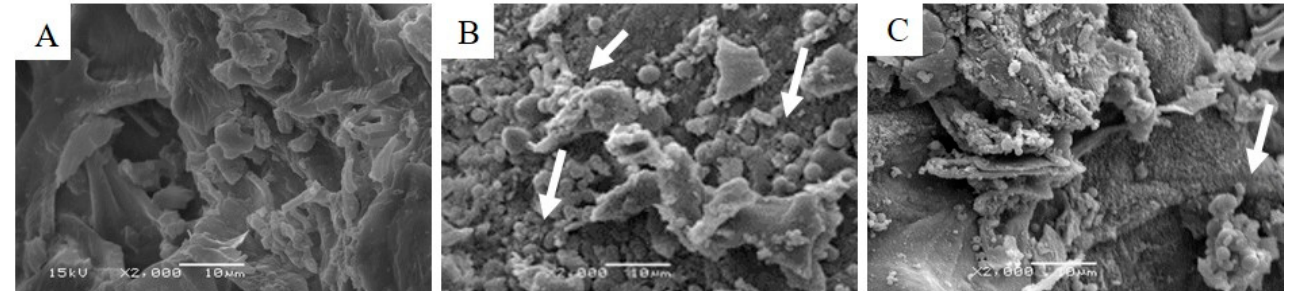
Figure 1. SEM micrographs of milled cocoa shell ( A ), milled cocoa shell particles after hydrothermal treatment (250 °C for 1 h) ( B ), and following ethanol extraction ( C ). The arrows in ( B ) point out surface-adhered droplets composed of lignin and lipids. Ethanol extraction on the hydrothermally treated solids has removed the majority of the surface-adhered droplets ( C ). The scale bars represent 10 µm.